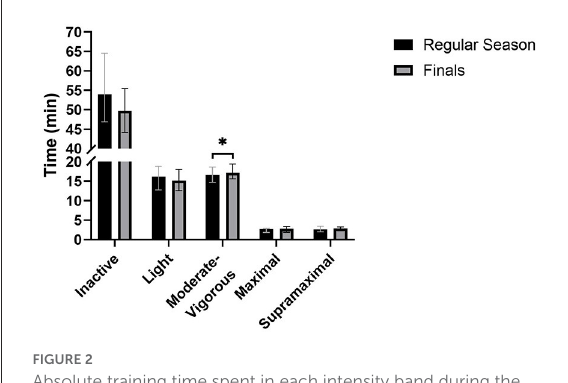
FIGURE2 Absolute training time spent in each intensity band during the regular season and finals. *Represents a significant difference between the regular season and finals. Error bars represent the upper and lower quartiles.